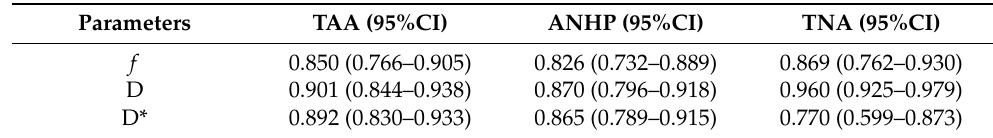
Table 3. ICC of the values between the two readers.